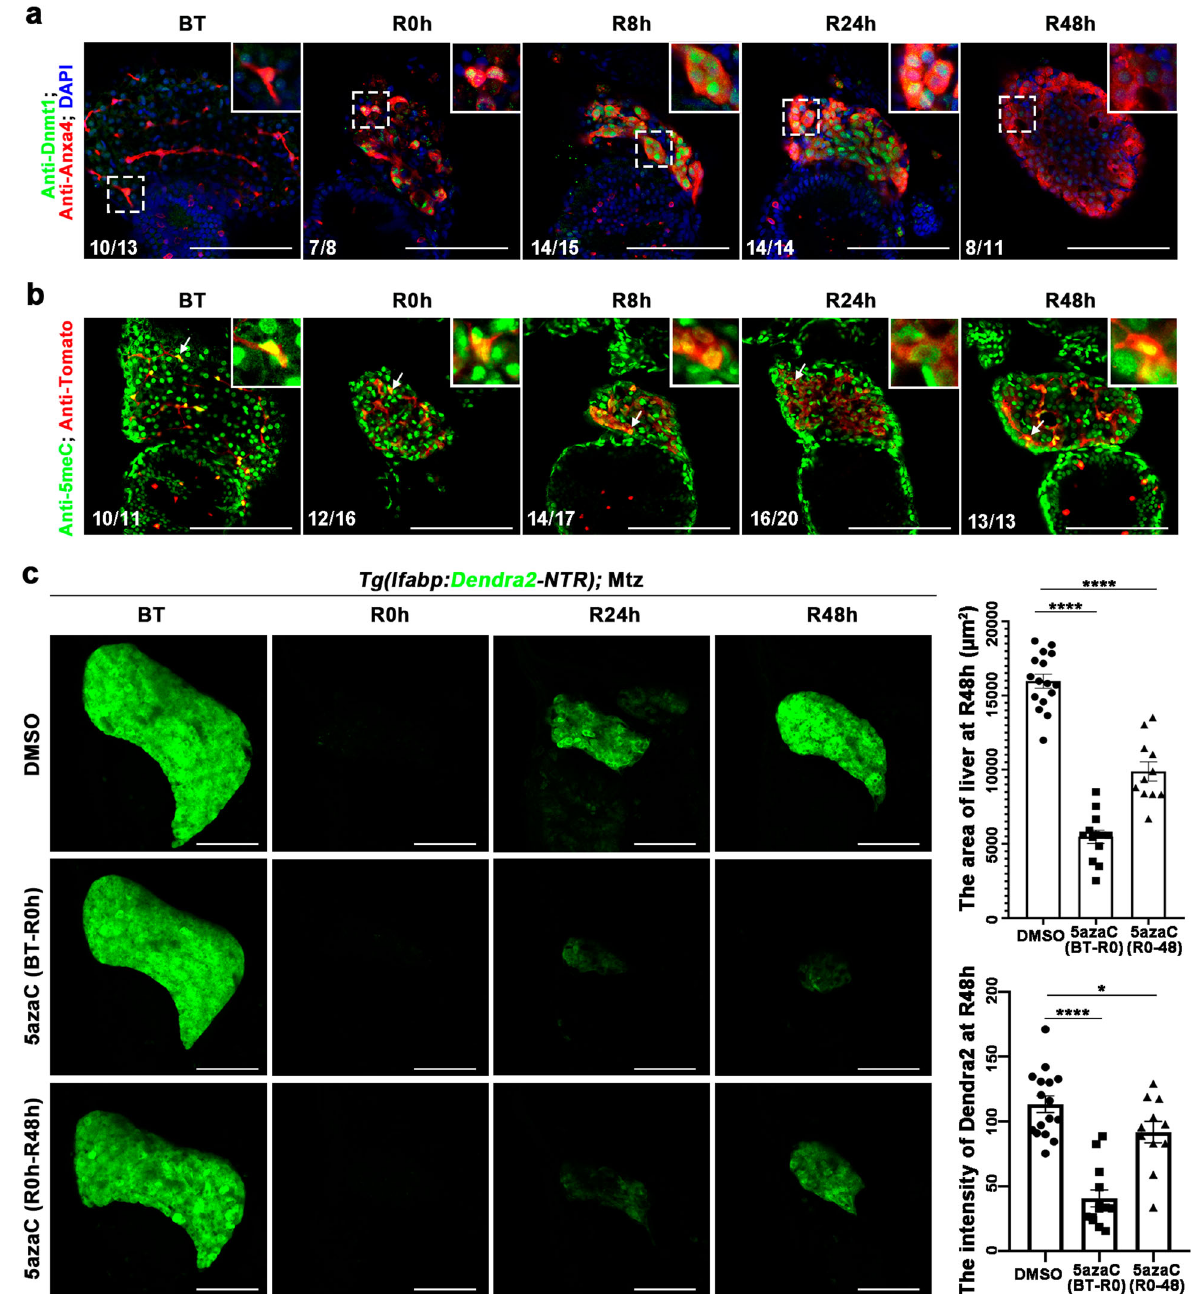
Fig. 1 DNA methylation governs BECs-mediated liver regeneration. a Single-optical section images showing the expressions of Anxa4 and Dnmt1 in regeneration livers of Tg(lfabp:Dendra2-NTR) from BT to R48h. Note that the expression level of Dnmt1 was upregulated in Anxa4 + cells from R0h to R24h. b Single-optical section images showing the expressions of 5meC and Tomato in Tg(lfabp:Dendra2-NTR; tp1:Tomato) double transgenic line from BT to R48h. Note that the expression of 5meC maintains in Tomato + cells from R0h to R24h (arrows). c Confocal projection images showing the liver regeneration from BT to R48h after 5azaC treatment from BT to R0h (early DNA methylation inhibition) and R0h to R48h (late DNA methylation inhibition). Quanti fi cation of the area of liver sizes and the intensity of Dendra2 expression at R48h. Asterisks indicate statistical signi fi cance: * P < 0.05; **** P < 0.0001 using t -tests analysis when compared to control. Numbers indicate the proportion of larvae exhibiting the expression shown. Scale bars: 100 µm; error bars, ±SEM. DAPI 4 ’ , 6-diamidino-2-phenylindole, BT before treatment, R regeneration time after the withdrawal of treatment (Fig. 4a and b). The expression of Bhmt and the ratio of that DNA methylation at the p53 locus derepresses the Alcam + Dendra2 − mature BECs also recovered in the p53 mutant mTORC1 signaling and induces BEC dedifferentiation. To explore the effects of early inhibition of DNA methylation at (Fig. 4c). As a consequence, the reduced size of regenerating liver the p53 locus on liver regeneration, we checked the expressions of caused by the early incubation of 5azaC was partially rescued in hepatocyte and BEC markers at R48h in the p53 mutant. Mutation the p53 mutant (Supplementary Fig. 6a – c). The rescued hepato- of p53 rescued the loss of cp and gc expressions caused by 5azaC